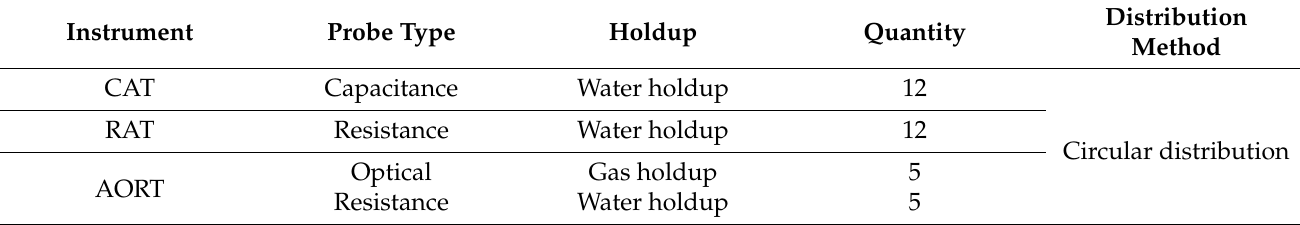
Table 2. Comparative analysis table of FSI, MPS and